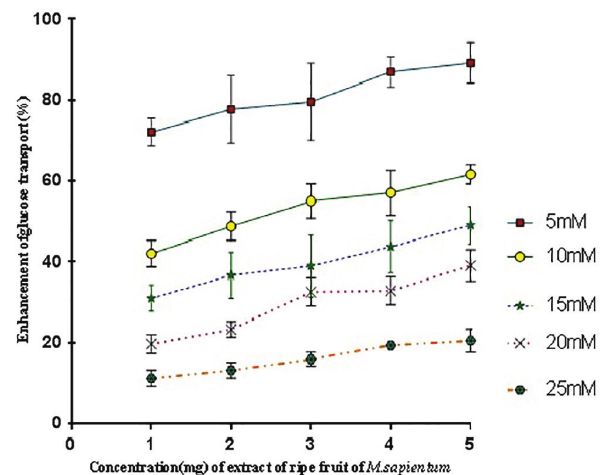
FIGURE 3 - Effect of extract of ripe fruit of Musa sapientum on the uptake of glucose by yeast cells. (Values are mean ± SD of triplicate determinations).